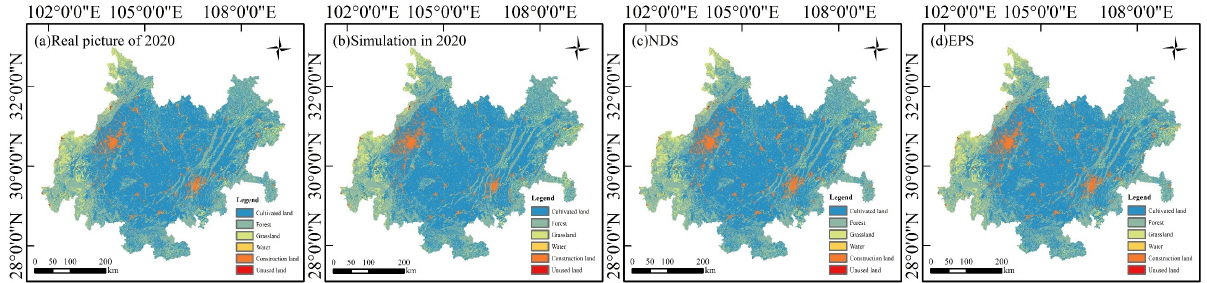
Figure 4. Comparison of simulation for 2020 and predictions of two scenarios in 2030.